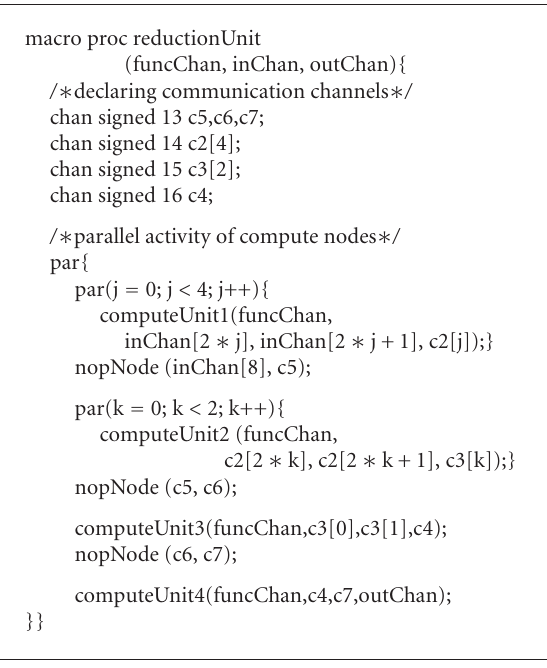
Algorithm 4: Code example for the moving window unit (simpli- fied version without initialization and border